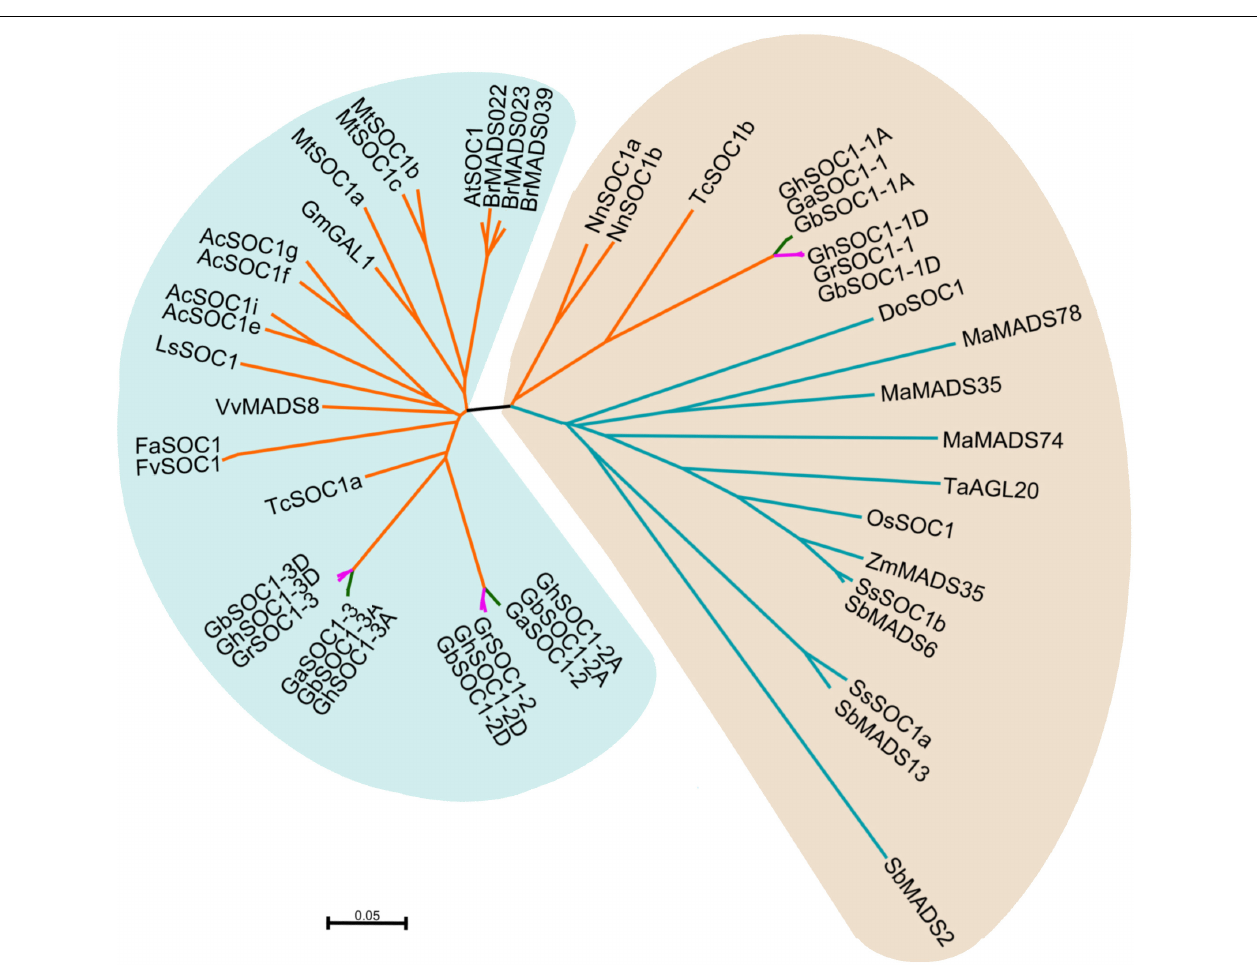
FIGURE 2 | Phylogenetic analysis of SOC1 -like genes in cotton and other plants. SsSOC1a and SsSOC1b in Saccharum spontaneum was download from the article (Fatima et al., 2020). Other SOC1 sequences were downloaded from NCBI and their accession numbers are given in Supplementary Table 2